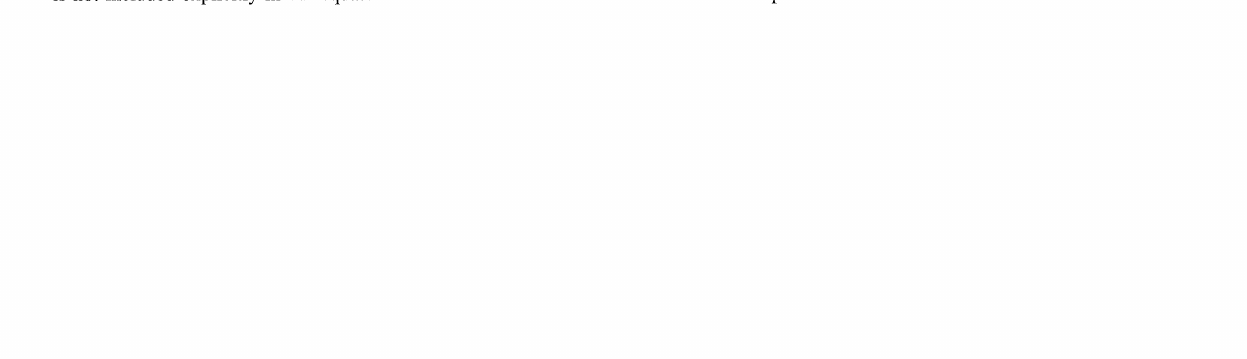
FIGURE The cell compartments and their interactions for the case of one population (syngeneic or allogeneic) only. Solid arrows indicate differentiation of cells from one compartment to the next, proliferation, or death; dashed arrows indicate the effects of thymic stroma, which is not included explicitly in our equations. Parameters indicate the rates of the various